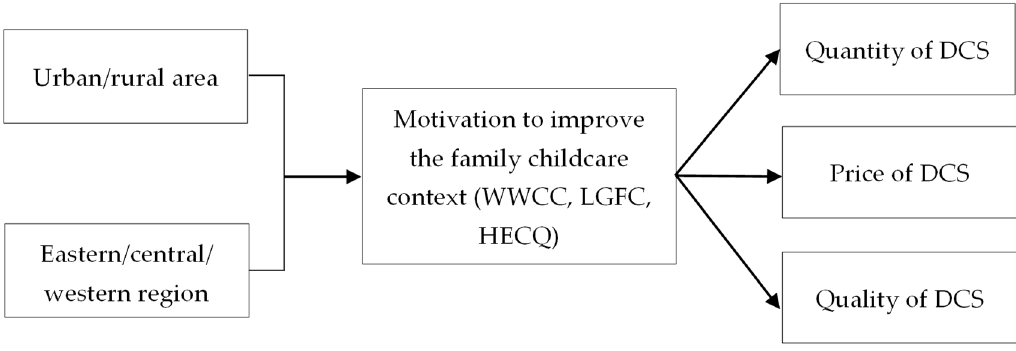
Figure 2. The moderating effect framework of FCC between RD and DCS.